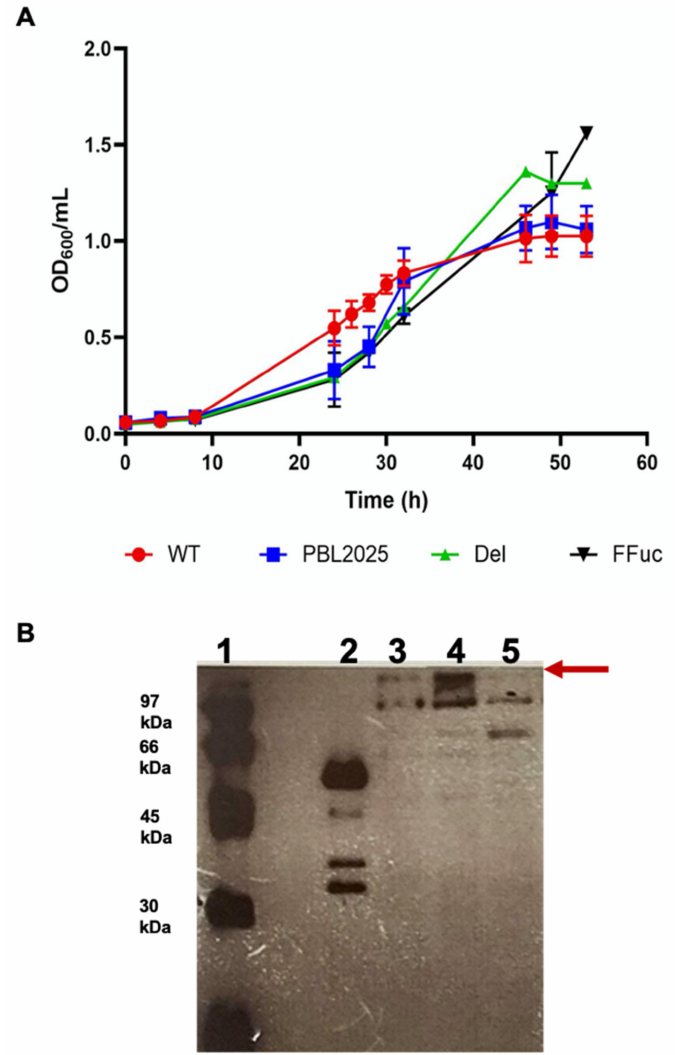
Figure 2. S. solfataricus wild type and mutant strains. ( A ) Representative growth curves of S. solfataricus wild type (WT), PBL2025, Del and FFuc strains (red, blue, green and black lines, respectively) in YCS medium at 80 ◦ C. Error bars reported represent standard deviations. ( B ) Western blot analysis, performed with anti- α - L -fucosidase antibody, on cellular extracts of WT , FFuc and Del mutants. Lane 1: ECL markers (97-66-45-30 kDa), lane 2: α - L -fucosidase 0.1 mg/mL; the additional bands observed are due to partial proteolysis as already reported [22]; lane 3: wild type extract; lane 4: FFuc extract; lane 5: Del extract. The apparent high molecular bands corresponding to the α -fucosidase in vivo are indicated by a red